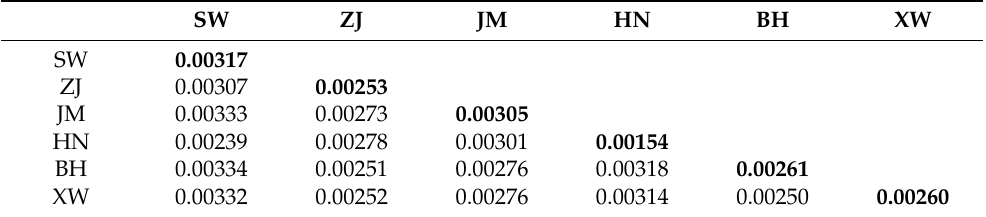
Table 4. Genetic distances between populations (below the diagonal) and genetic distances within six Chinese populations (in bold values) of Mytella strigata according to the partial F-12S gene. JM, Jimei; SW, Shanwei; XW, Xuwen; BH, Beihai; ZJ, Zhanjiang; HN, Hainan. SW ZJ JM HN BH XW